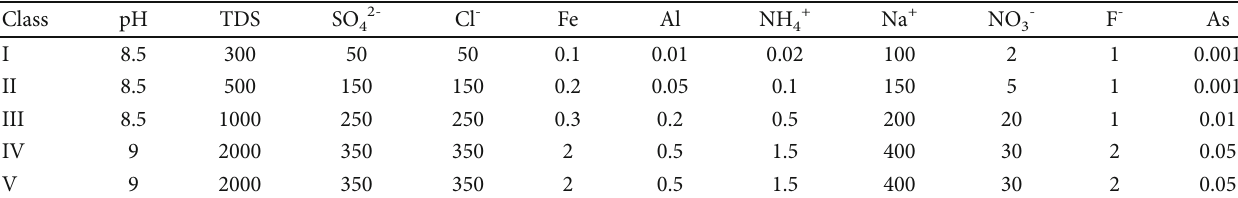
Figure 2: Location and number of sampling points. Table 1: Conventional indexes and limits of groundwater quality